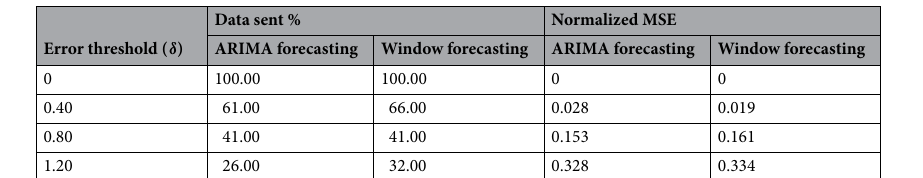
Table 2. Data reduction and normalized error comparison between window forecasting and ARIMA (p = 3, d = 1, q = 0) forecasting; number of samples = 200.